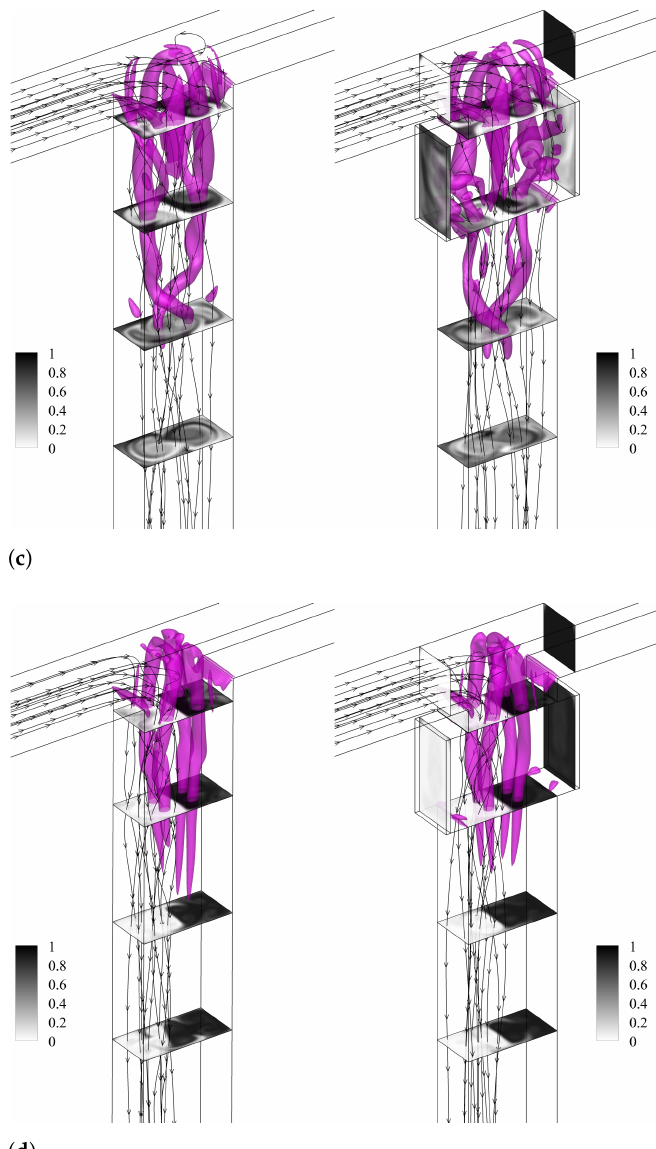
Figure 2. Isosurfaces of the λ 2 vortex-indicator and contours of non-dimensional dye concentration at the Y = − 0.375, − 1.875, − 3.375, and − 4.874 cross-sections along the mixing channel for TJ case (left panel) and TJC case (right panel). Considered Reynolds numbers: ( a ) Re = 100, ( b ) Re = 200, ( c ) Re = 300, and ( d ) Re =